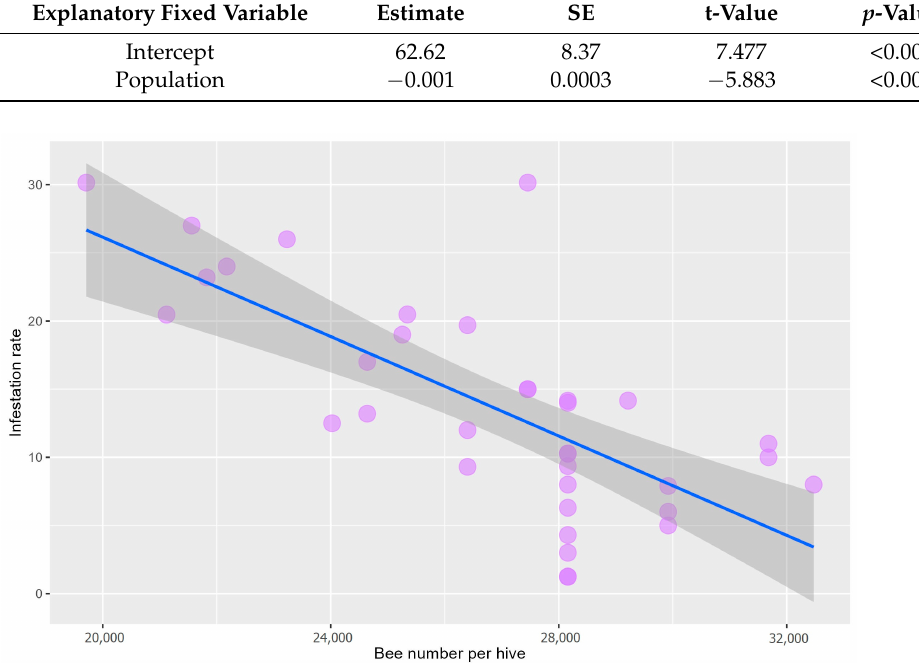
Figure 3. The relationship between Tropilaelaps mercedesae mite infestation rate and honey bee pop- ulation (honey bee number) per beehive. Purple circles represent the infestation rate for each bee population size. Blue solid lines with gray loess curves show the significant relationship between mite infestation rate and bee population using linear